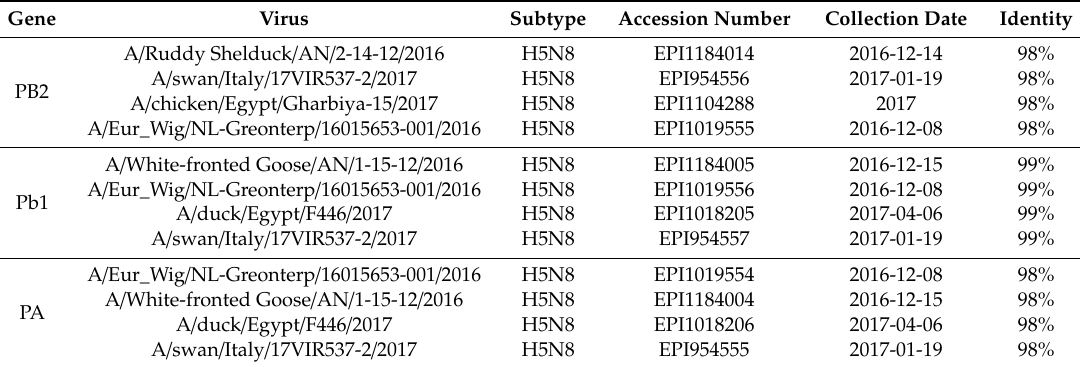
Table 1. Nucleotide sequence identities between the EG-VG1099 (H5N2) virus and nearest homologues in the GenBank and GISAID